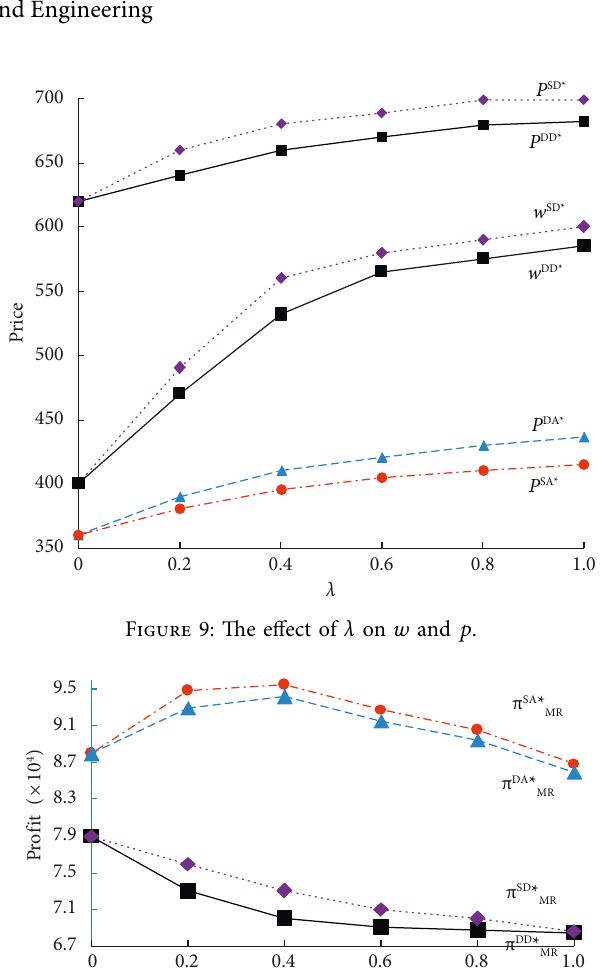
Figure 10: The effect of λ on π